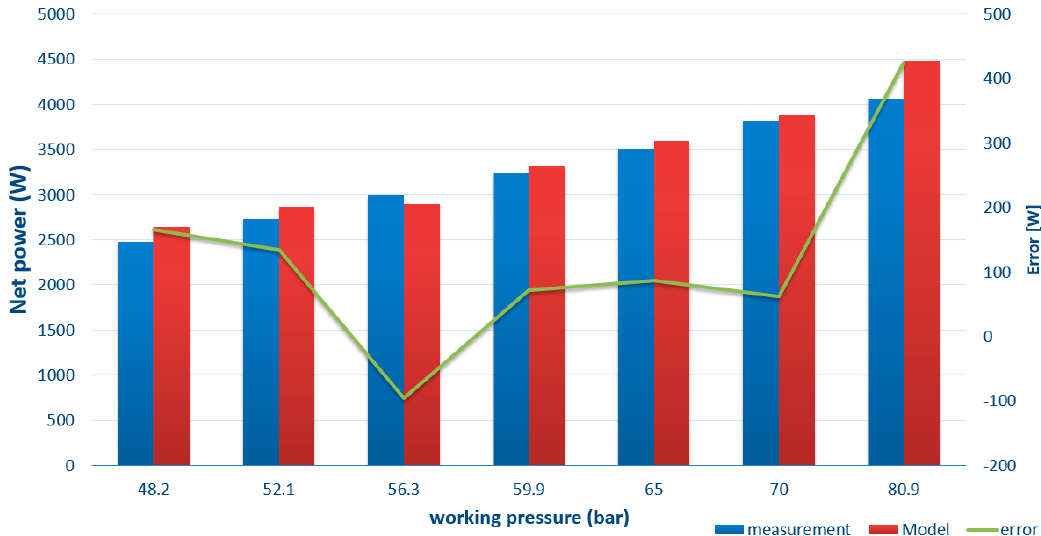
Figure 8. The comparison of the numerical model and experimental data.